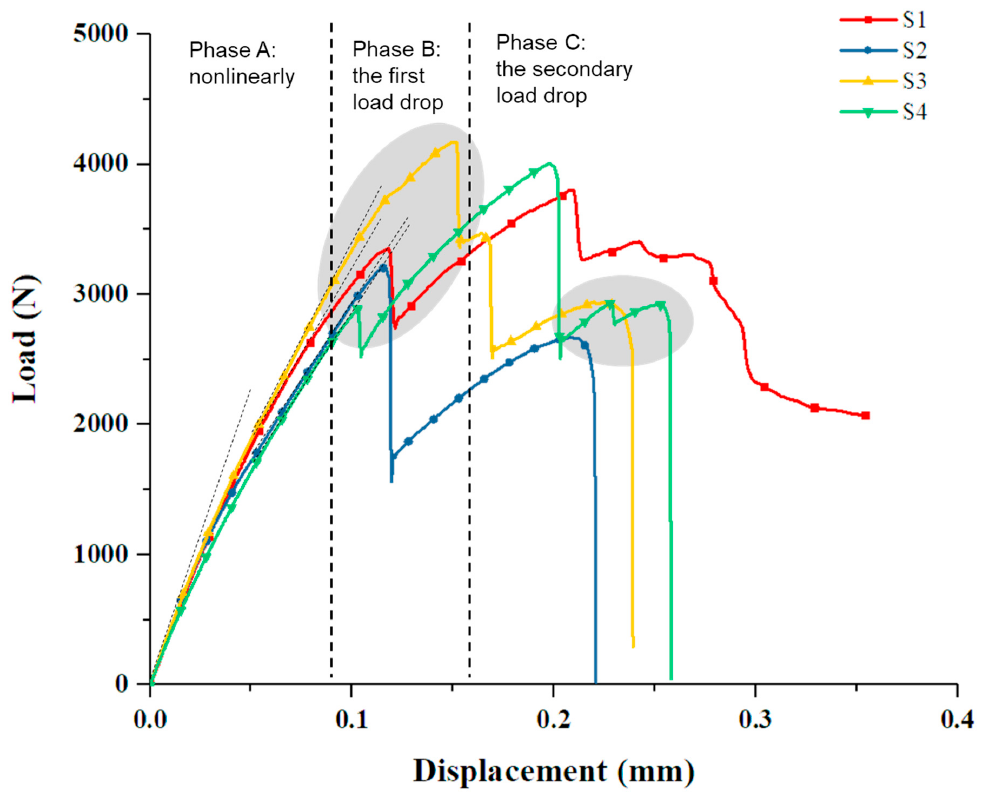
Figure 3. Load and displacement relationship of the test specimens.